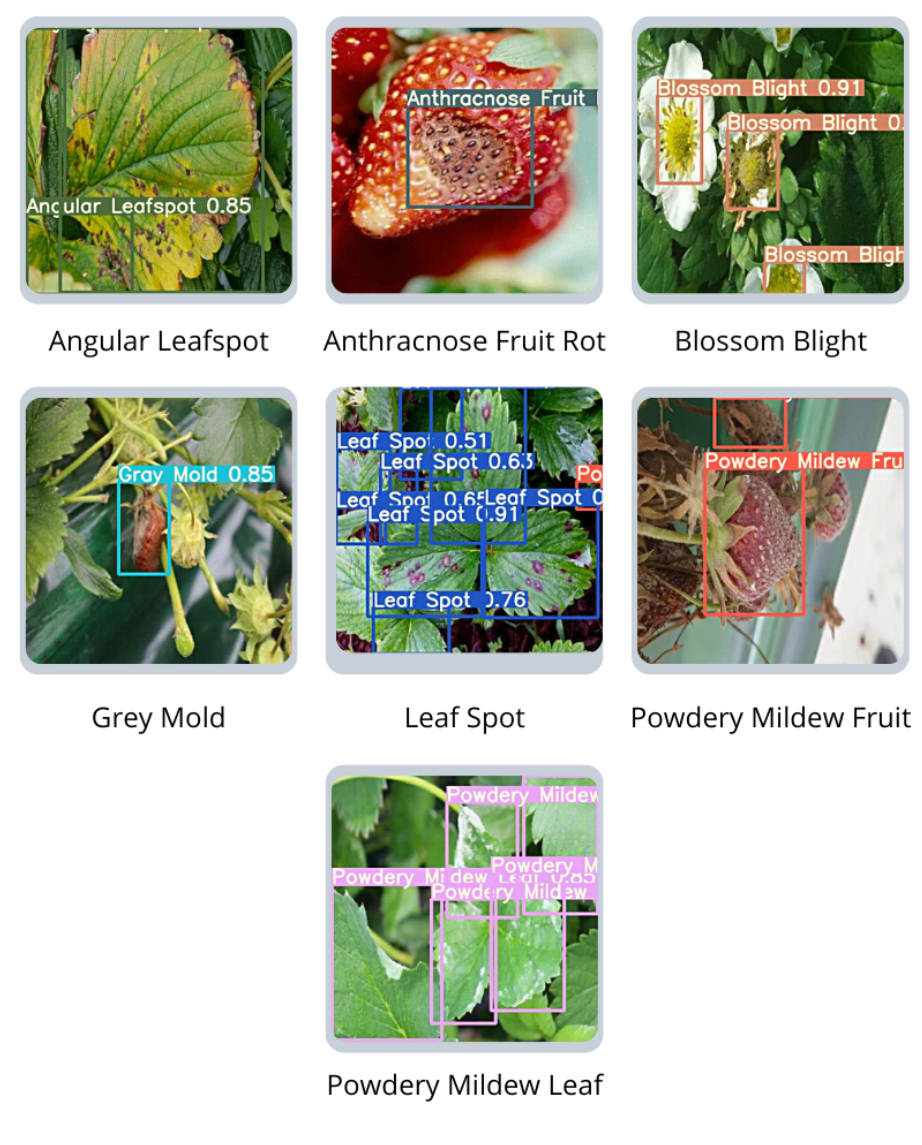
Figure 19. Detected diseases with Yolo v5